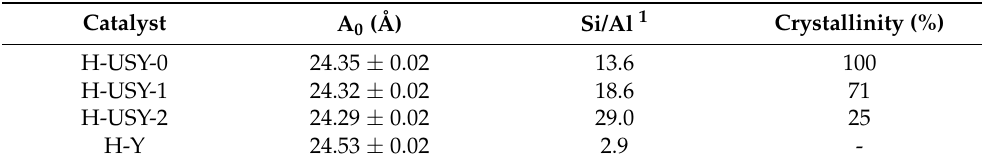
Table 2. Unit cell parameter, framework Si/Al ratio, and crystallinity obtained from XRD measure- ments.